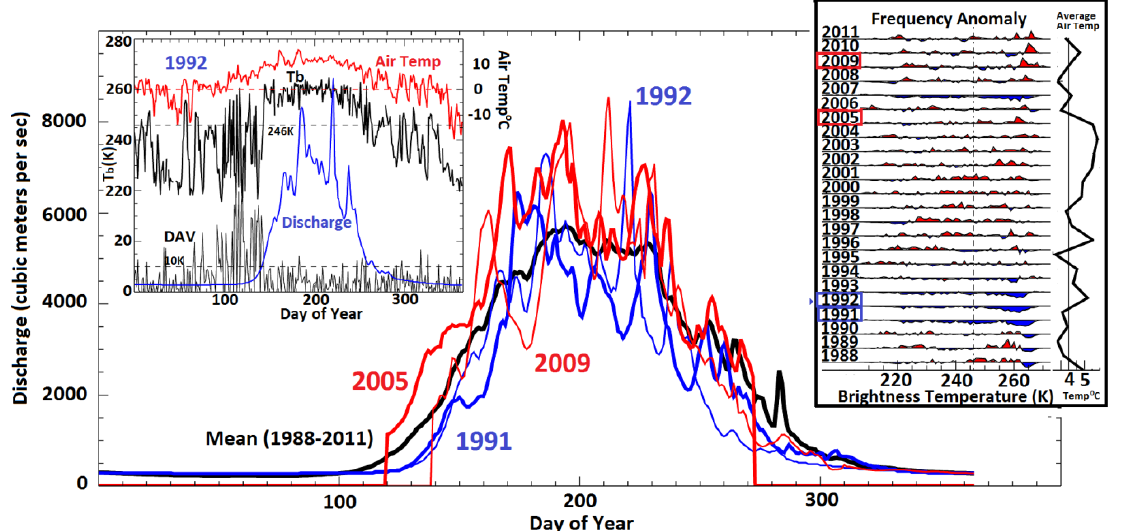
Figure 8. Discharge for Copper River at Million Dollar Bridge near Cordova, AK (USGS anomaly years in blue (1991 and 15214000, see Figure 3 for location) for two negative T b 1992) and two positive T anomaly years in red (2005 and 2009) compared to the mean b 1988 to 2011 (thick black